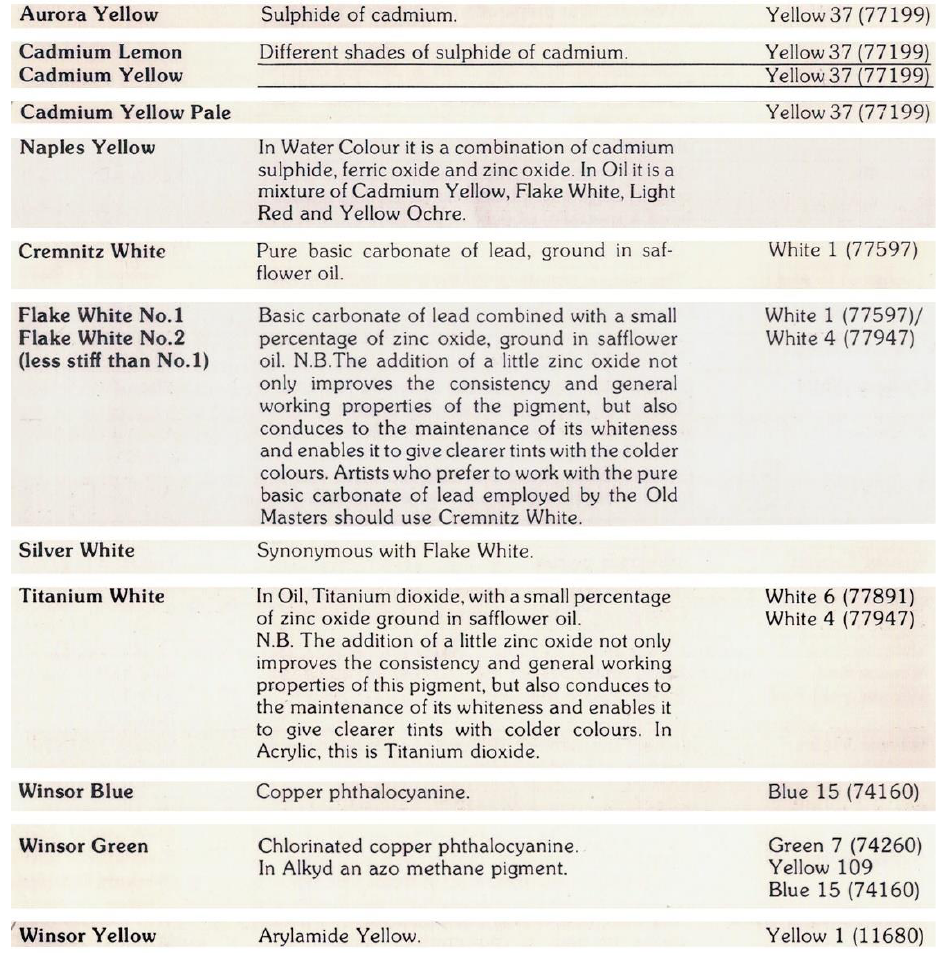
Figure A2. Selected compositions of pigments, listed in the catalogue of W&N from 1982, used for manufacturing of oil, watercolours, acrylic and alkyd paints for artists.